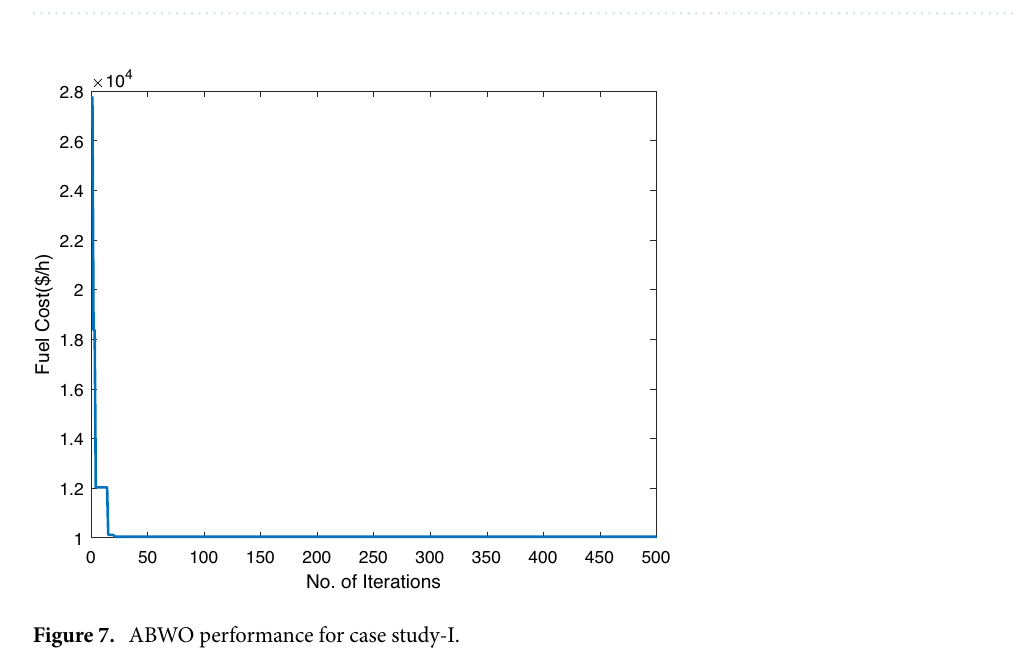
Figure 7. ABWO performance for case study-I.